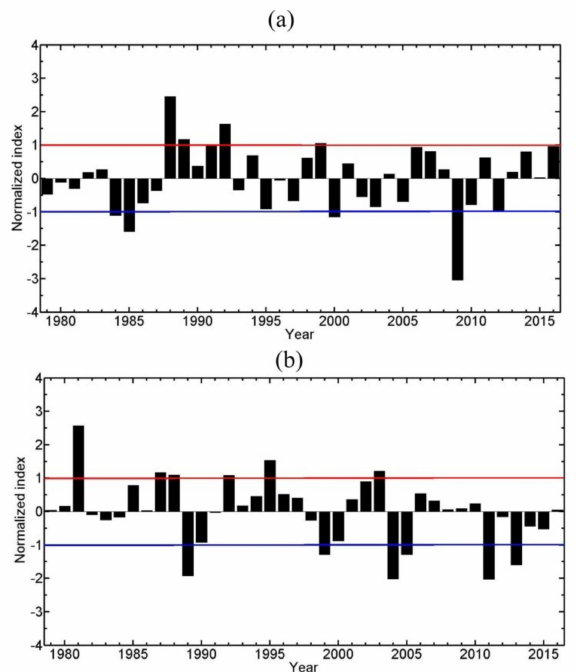
Figure 11. Time series of the normalized wintertime Arctic Oscillation (AO) in ( a ) and Artic Dipole (AD) indices in ( b ). Red and blue lines denote the limits of 1 and − 1,